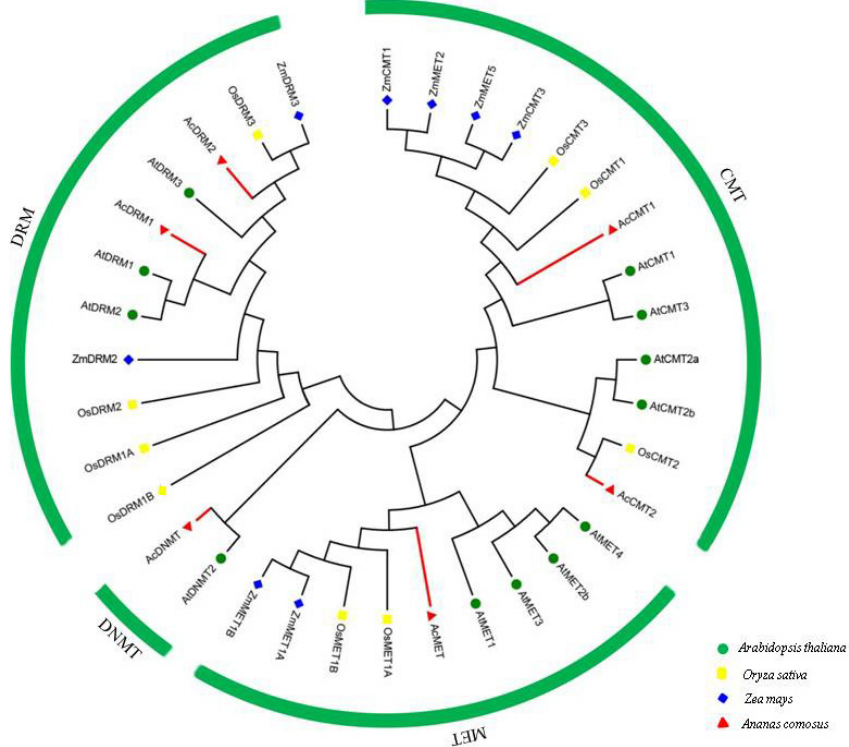
Figure 4. Phylogenetic analysis of AcC5-MTases. Different species are represented in different colors, as shown in the legend.